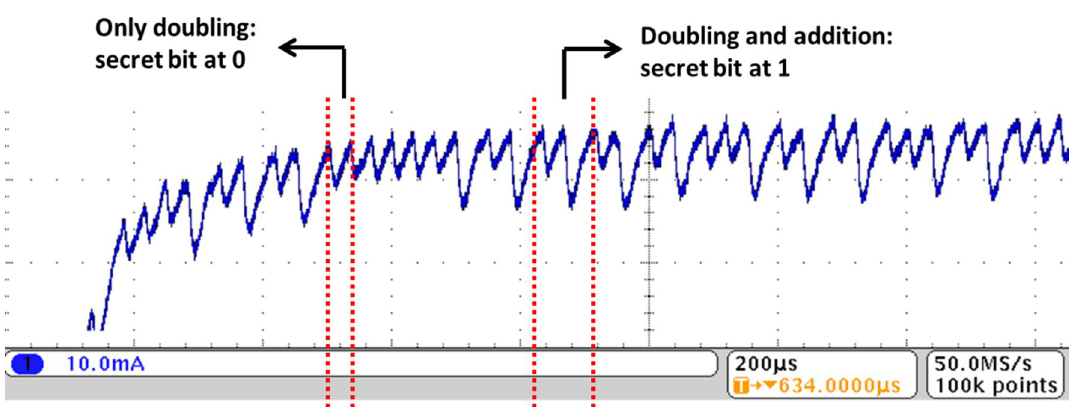
Figure 1. Example of power consumption trace for a circuit with a naïve implementation of Elliptic Curve Cryptography (ECC).